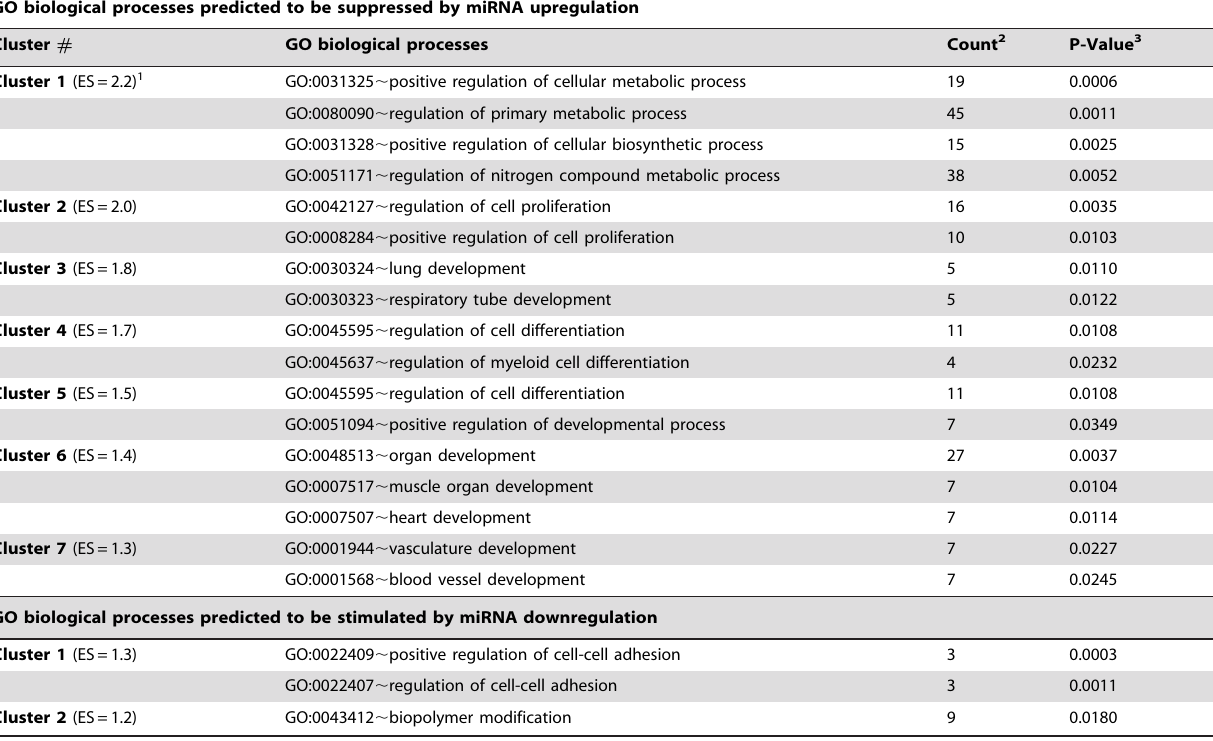
Table 4. Functional annotation clusters of enriched GO biological processes predicted to be regulated by miRNA changes in senescent IMR90 and MRC5